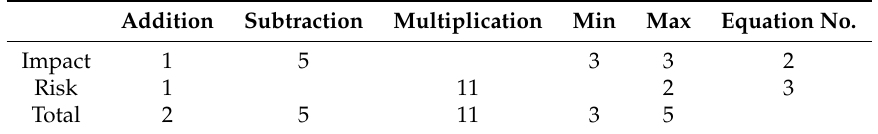
Table 11. Arithmetic operations of existing